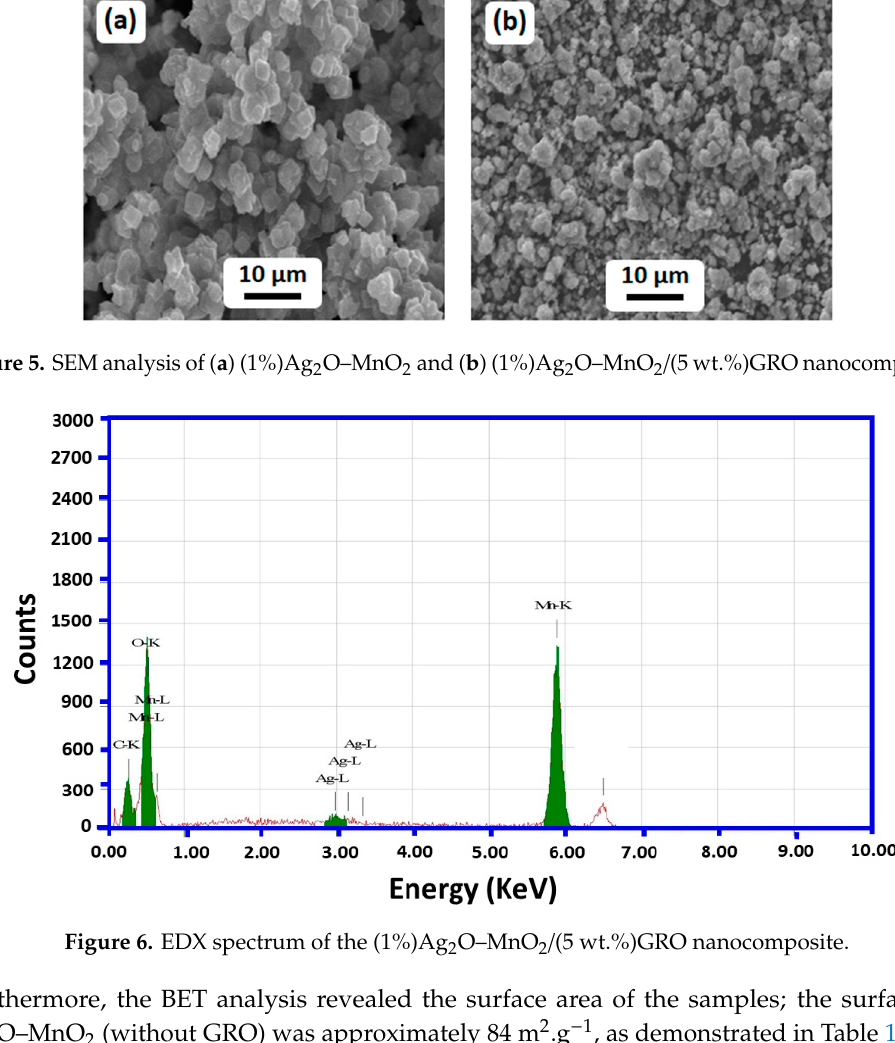
Table 1. Catalytic oxidation of BnOH, catalyzed by different catalysts.